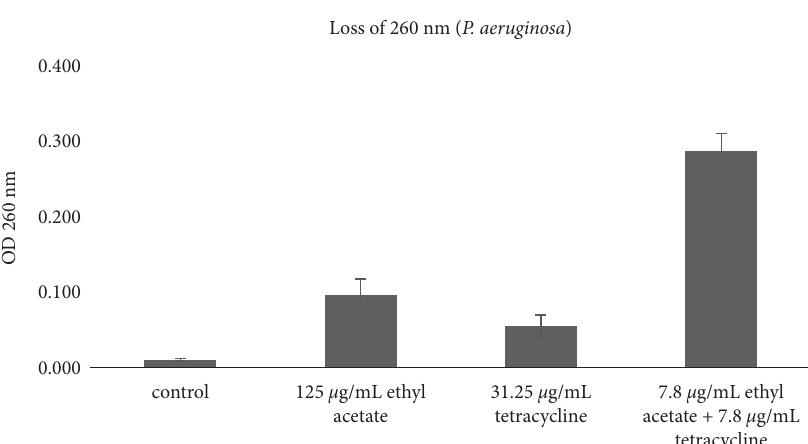
Figure 3: Loss of 260nm absorbing materials on P.